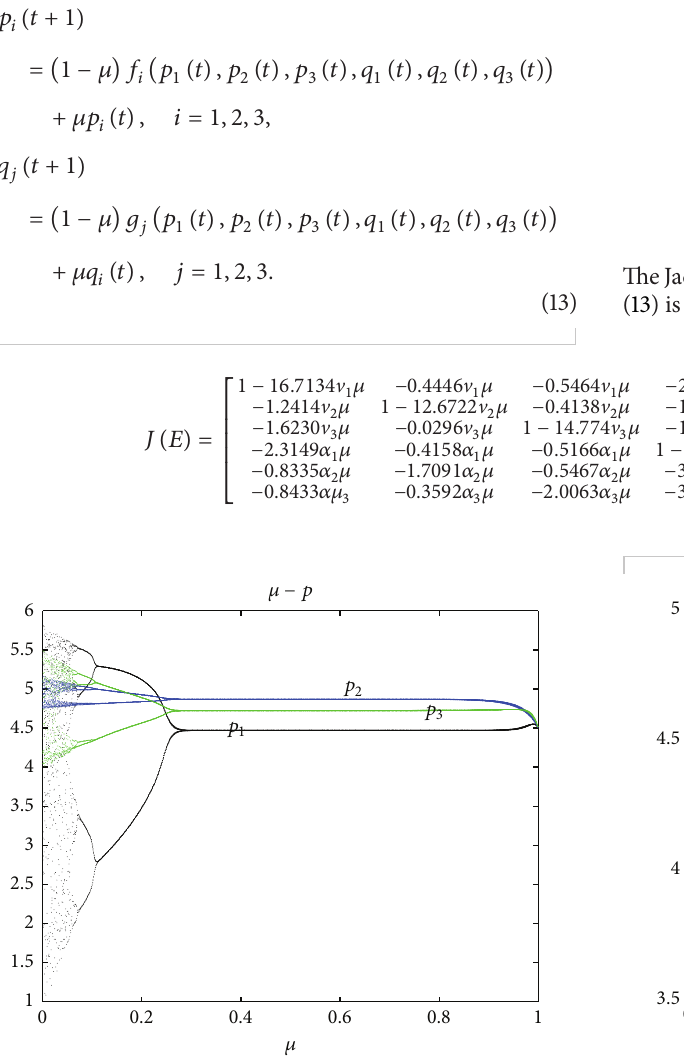
Figure 12: Chaos control of 𝑝 𝑖 with parameter 𝜇 . Figure 13: Chaos control of